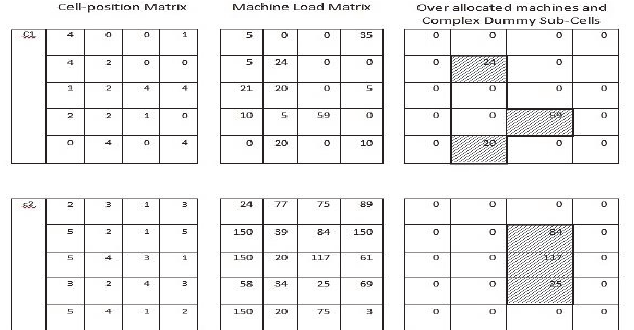
Fig. 14. Results of CDSB Equation for first period in final solution of experiment number 8